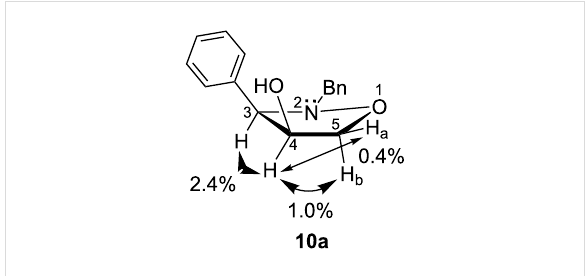
Figure 3: Selected NOE enhancements observed in the isoxazolidin-4- ol cis - 10a . The arrows show the NOESY